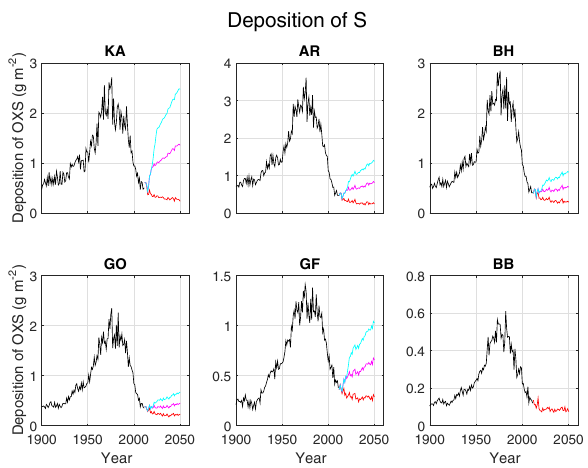
Figure 7. Annual deposition of sulfur from all emission sources (gm − 2 ) in six basins of the Baltic Sea (defined in Fig. 2), for the years 1900 to 2050. The red line corresponds with shipping scenario 3 and the magenta and cyan lines correspond with shipping sce- narios 4 and 5, respectively (scrubber + atmospheric deposition). The black line shows historical shipping (derived in Omstedt et al.,